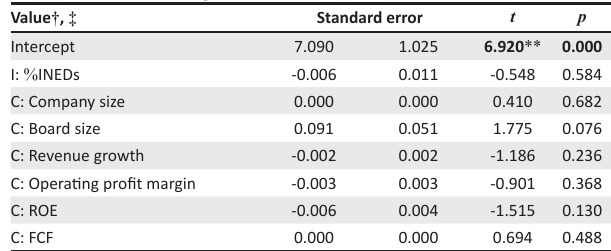
TABLE 6: Mixed-model regression results.